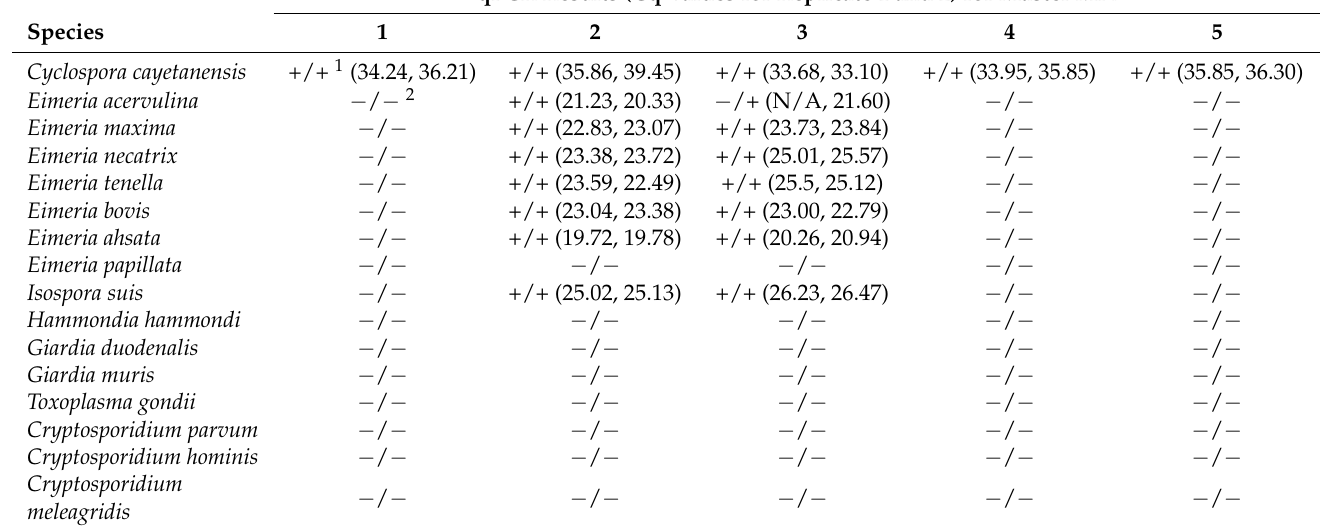
Table 1. Master mix exclusivity